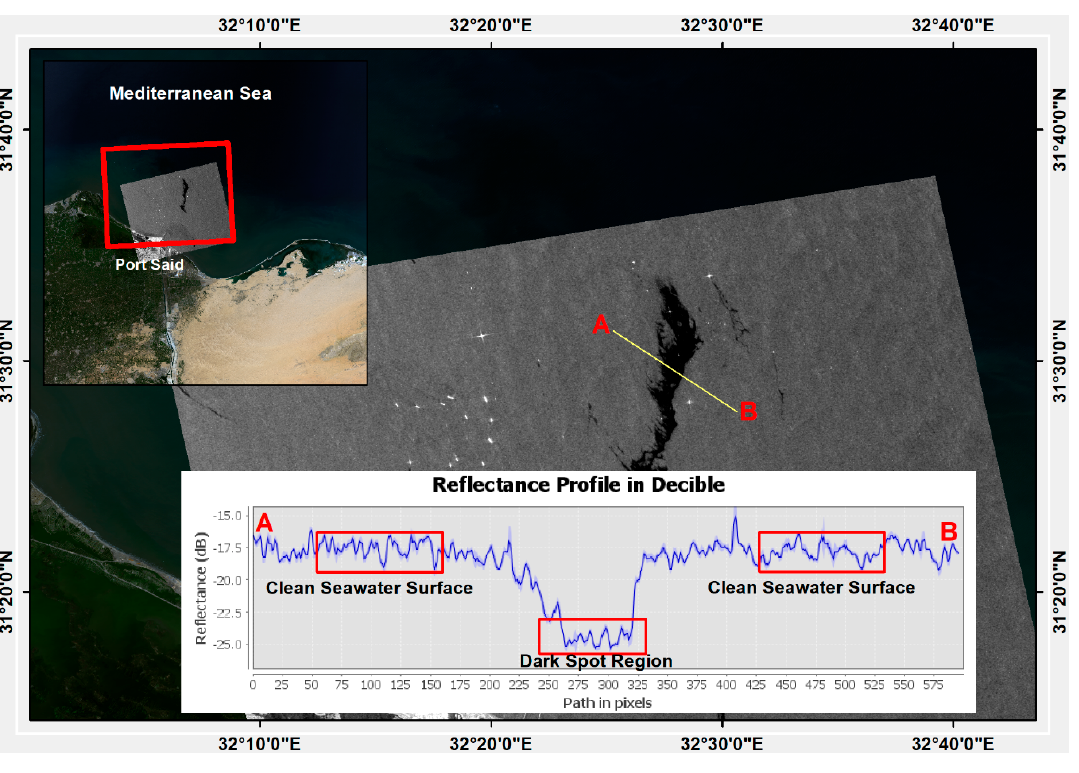
Figure 6. A profile plot for the spill event to monitor its reflectance, AandB = normal seawater reflectance, and the top 2 red squares are showing the reflectance of the clean seawater, the bottom red square outlines the reflectance of the dark spot area of oil pollution.